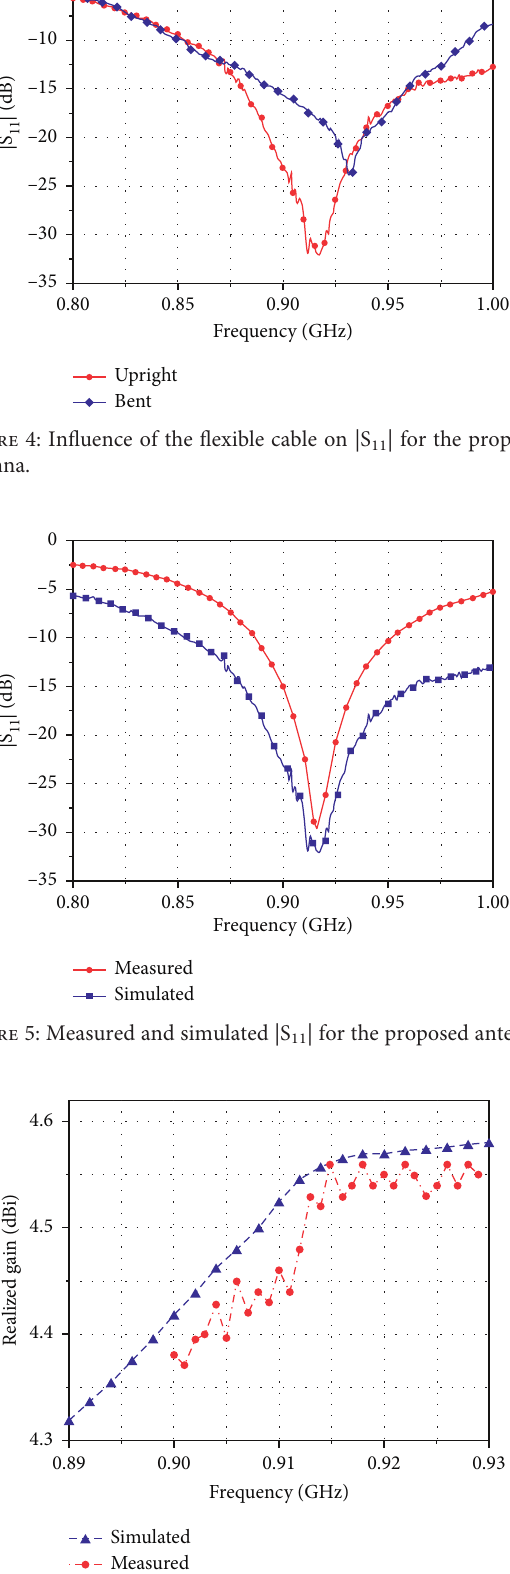
Figure 6: Measured and simulated gain of the antenna.